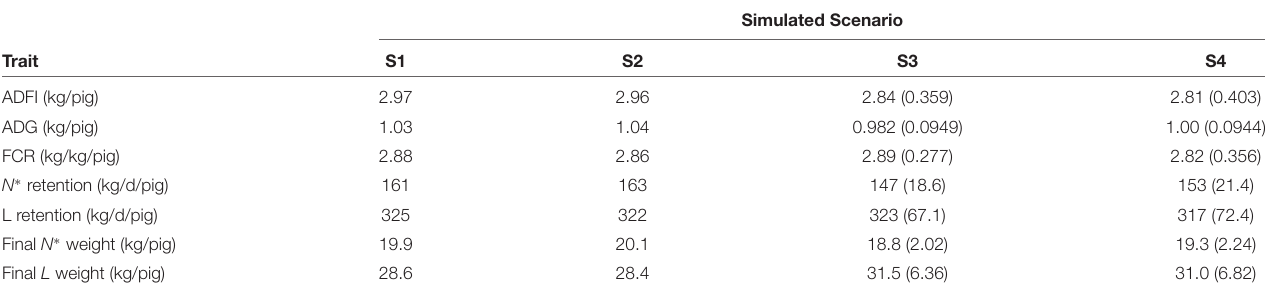
TABLE 3 | Summary statistics of average daily feed intake (ADFI); average daily gain (ADG); feed conversion ratio (FCR); protein ( N ∗ ) retention; lipid ( L ) retention; final protein ( N ∗ ) weight; and final lipid ( L ) weight in each of the four simulated scenarios in terms of mean values (S1 and S2 for the average pig) and mean (SD) values (S3 and S4 for the population of pigs).